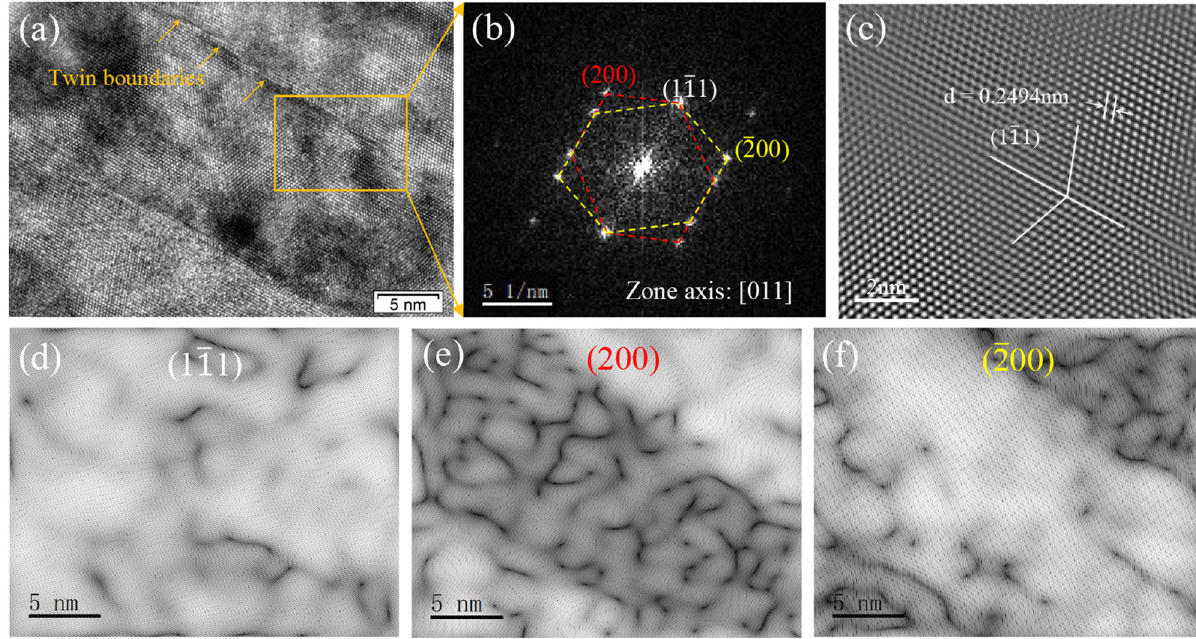
Figure 4: The partial HRTEM images of the J region of Figure 3 ( a ) of: ( a ) HRTEM image of FCC phase, ( b ) FFT of orange rectangle in ©, ( c ) partial IFFT of ( a ) , ( d – f ) ( 11¯1 ) FCC , ( 200 ) FCC , and ( 2¯00 ) FCC lattice fringes of ( a ) obtained by fi ltering.